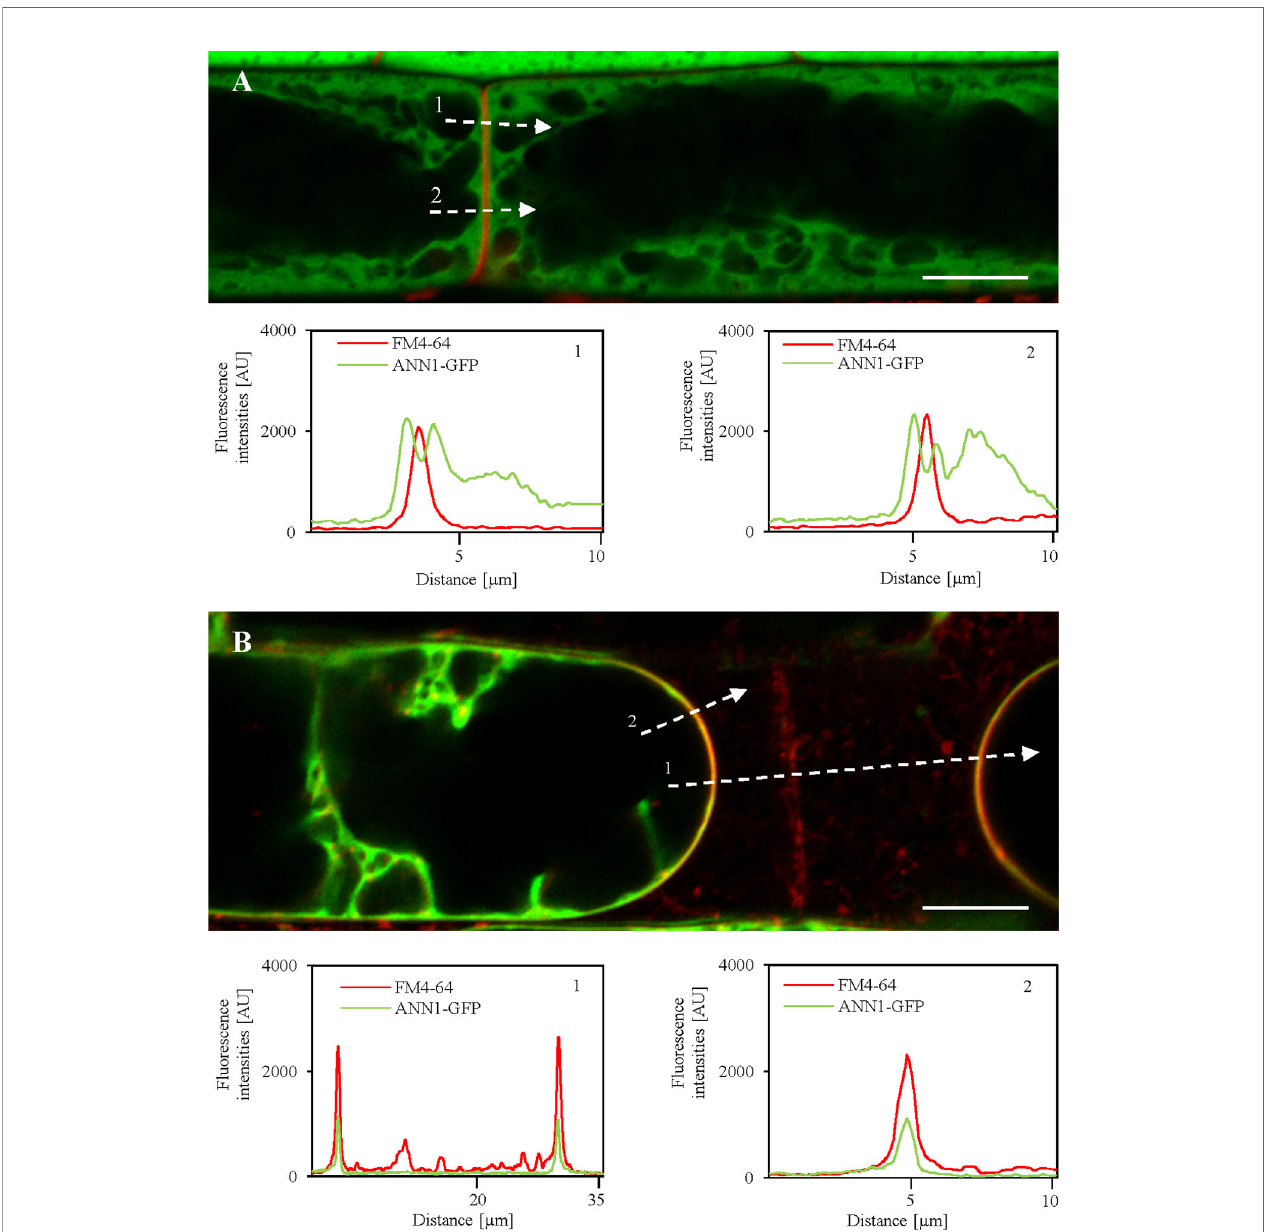
FIGURE 8 | Relocation of ANN1-GFP in plasmolyzed root epidermal cells to the FM4-64-labeled plasma membranes after salt stress as revealed by high-resolution Airyscan CLSM. (A) Root epidermal cells in the elongation root zone carrying ANN1-GFP and co-labeled with FM4-64 (red) for detection of the plasma membrane under control conditions. Fluorescence intensity pro fi les measured along the dotted white lines 1 and 2 in (A) showing distinctly separated ANN1-GFP and FM4-64 peaks, suggesting no obvious colocalization. (B) Salt stress causes relocation of ANN1-GFP to FM4-64 labeled plasma membranes in plasmolyzed root epidermal cells of elongation root zone. Fluorescence intensity pro fi les measured along the dotted white lines 1 and 2 in (B) showing a strong overlap of FM4-64 and ANN1- GFP peaks, suggesting their colocalization. Scale bars = 10 m